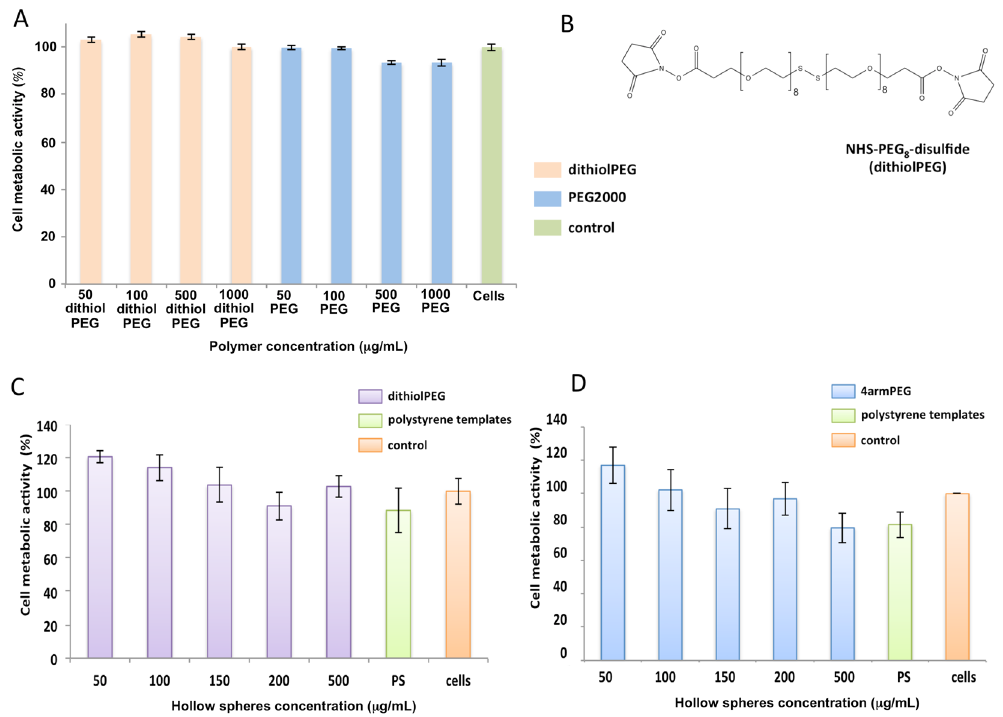
Figure 4. Cell metabolic activity on rat cardiomyoblasts H9C2 treated with control polymers and hollow spheres. ( A ) Linear dithiolPEG, linear PEG2000 after 24 hours of exposure and ( B ) the dithiolPEG chemical structure; alamarBlue ® assay was carried out on the dithiolPEG (orange), PEG2000 (blue), and untreated cells (green) (n = 3, p < 0.05). Cell metabolic activity on the collagen-dithiolPEG hollow spheres ( C ) and